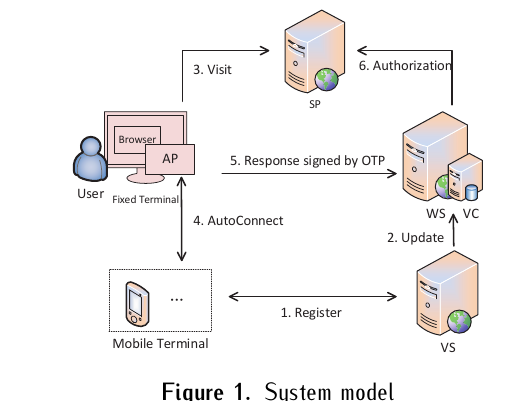
Figure 1. System model Figure 2. Three-level account